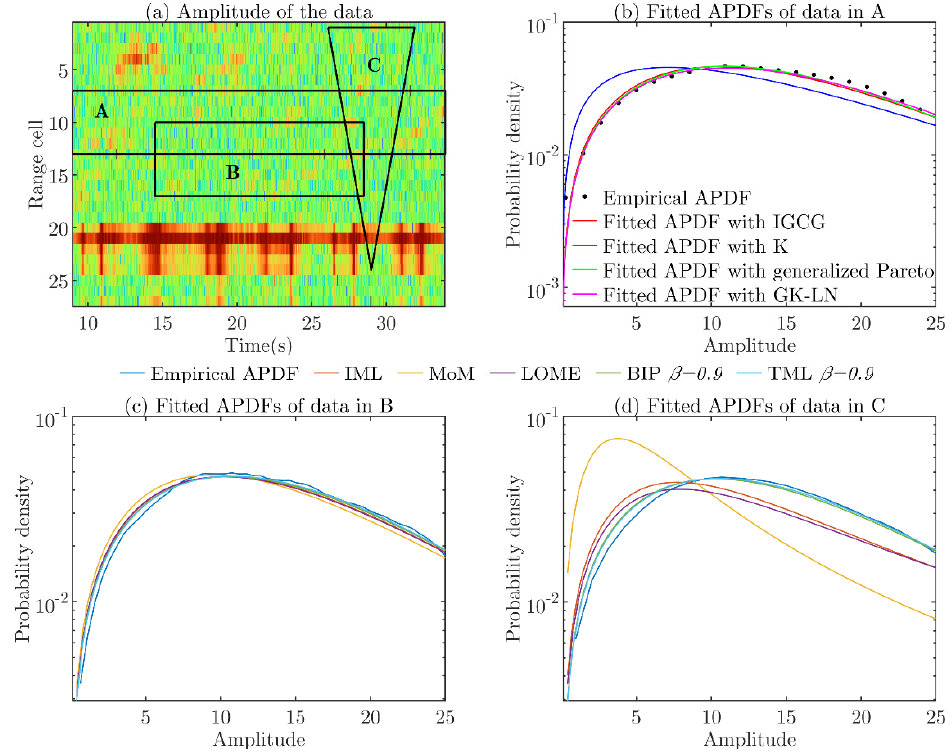
Figure 7. Performance comparison of the five estimators on one measured dataset of the IPIX radar database: ( a ) the amplitude map of the data and three areas for test; ( b ) empirical APDF of the data in the area A versus the fitted APDFs using the four types of distributions; ( c ) empirical APDF of the data in the area B without outliers versus the ICCG distributions fitted by the five estimators; ( d ) empirical APDF in the area C with outliers versus the fitted ICCG distributions.